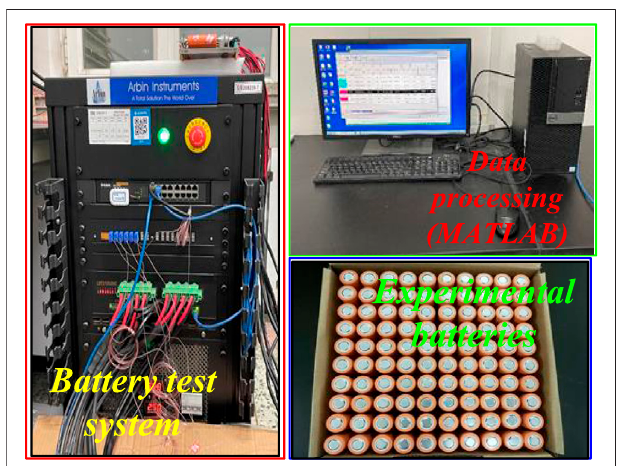
FIGURE 3 | Experimental